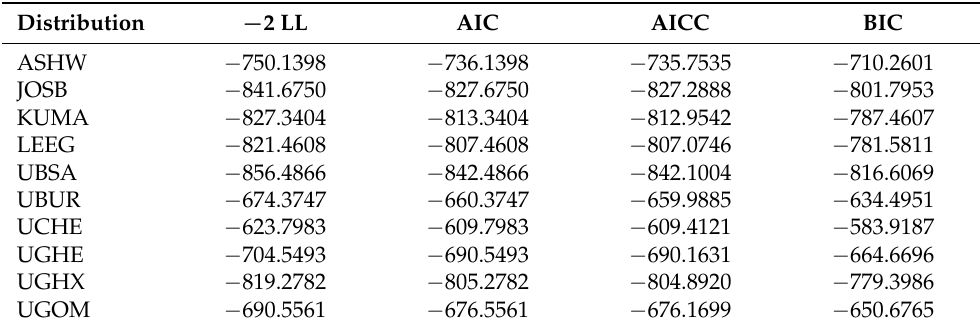
Table 14. Values of the indicated likelihood-based statistic and distribution for τ = 0.75 with data related to fat percentage at the